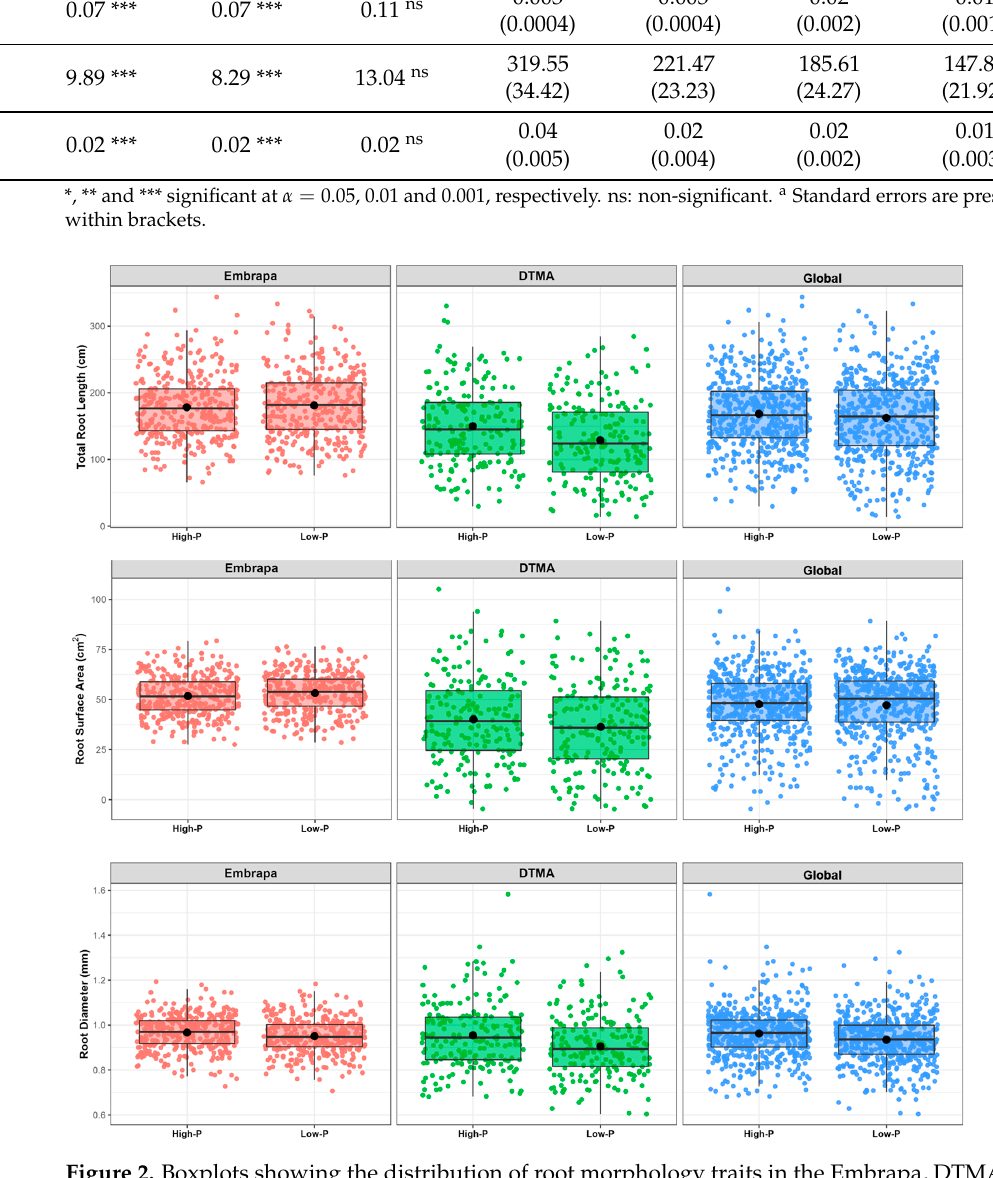
Figure 2. Boxplots showing the distribution of root morphology traits in the Embrapa, DTMA and for the global maize panels in high- and low- P concentrations. Phenotypes are BLUEs for root length in cm (RL), root surface area in cm 2 (SA) and root diameter in mm (RD).